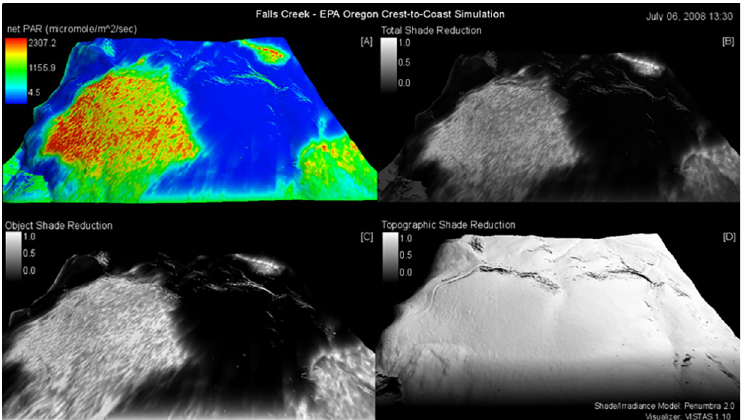
Fig 9. Falls Creek open and forest-sites simulation still-frame. Still-frame from S2 Video of July 06th, 2008 at 2:30pm. All shade reductions are scaled from 1.0 to 0.0, where 1.0 is no reduction and 0.0 is full reduction. Sub frames: (A) net solar energy as PAR ( μ moles/m 2 /s), (B) Total shade reduction (0.0–1.0), (C) Object shade reduction (0.0–1.0), (D) Topographic shade reduction (0.0–1.0). For all (0.0–1.0) shade reductions 1.0 is no reduction and 0.0 is full reduction. See S2 Video for full animation of this